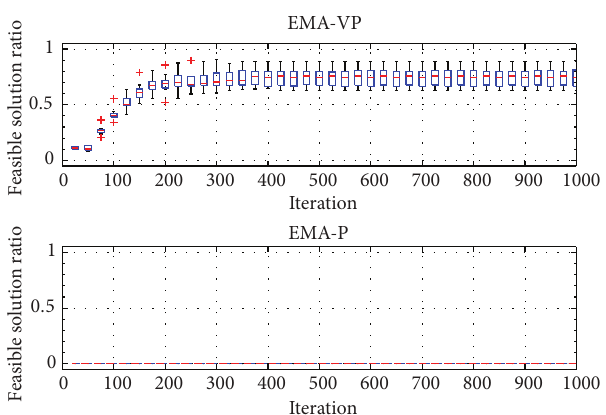
Figure 8: Ratio of feasible solutions for EMA-VP and EMA-P for RC 204.2.